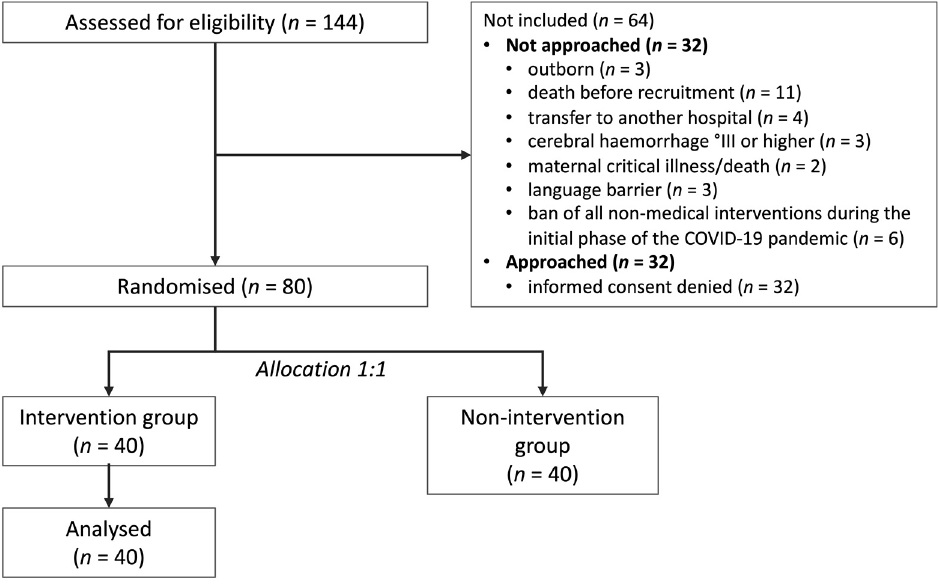
Figure 1. Flow chart of the included and excluded participants of the study. Table 1. Clinical characteristics of participants .